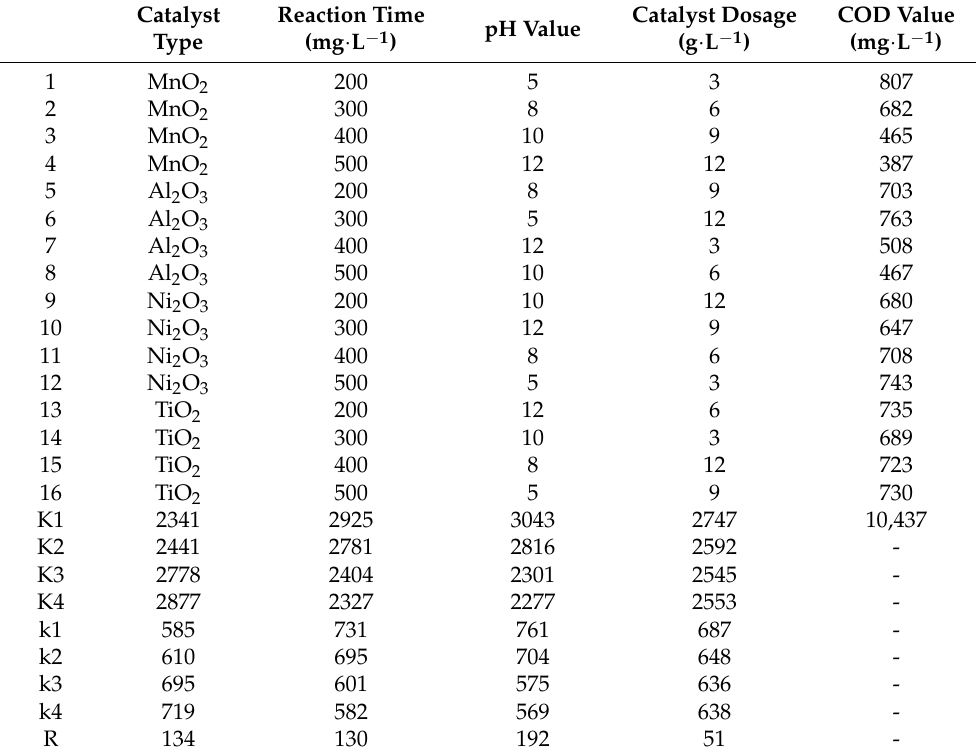
Table 3. Results of orthogonal